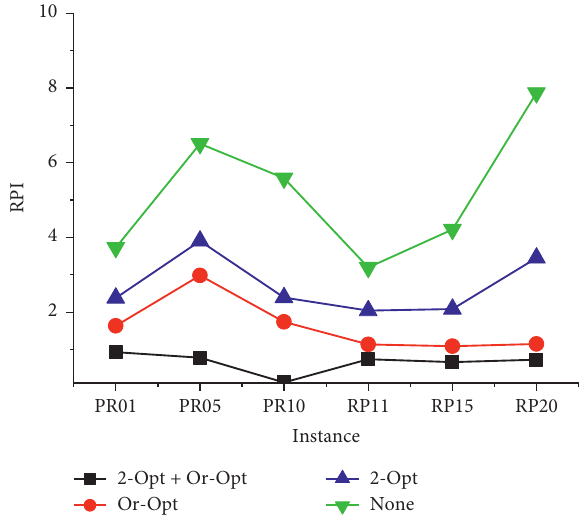
Figure 10: Comparisons of postoptimization. Table 5: Comparisons of HFOA with the state-of-the-art